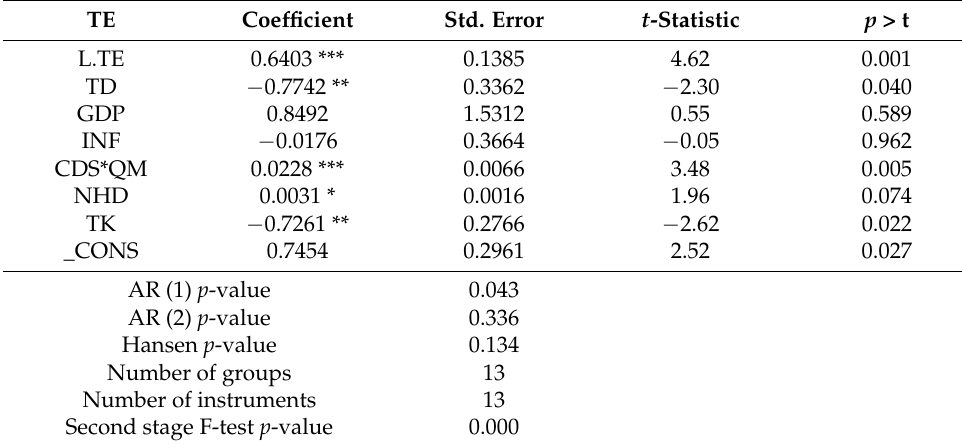
Table 4. The estimation result of Model